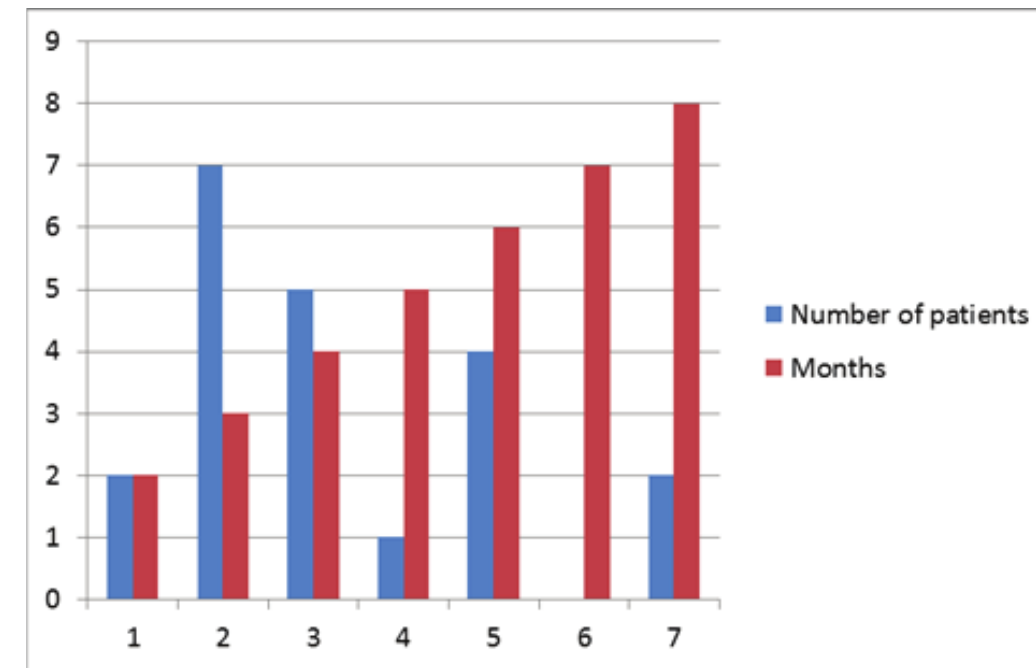
Figure 3: Spontaneous recovery period of ED following pelvic